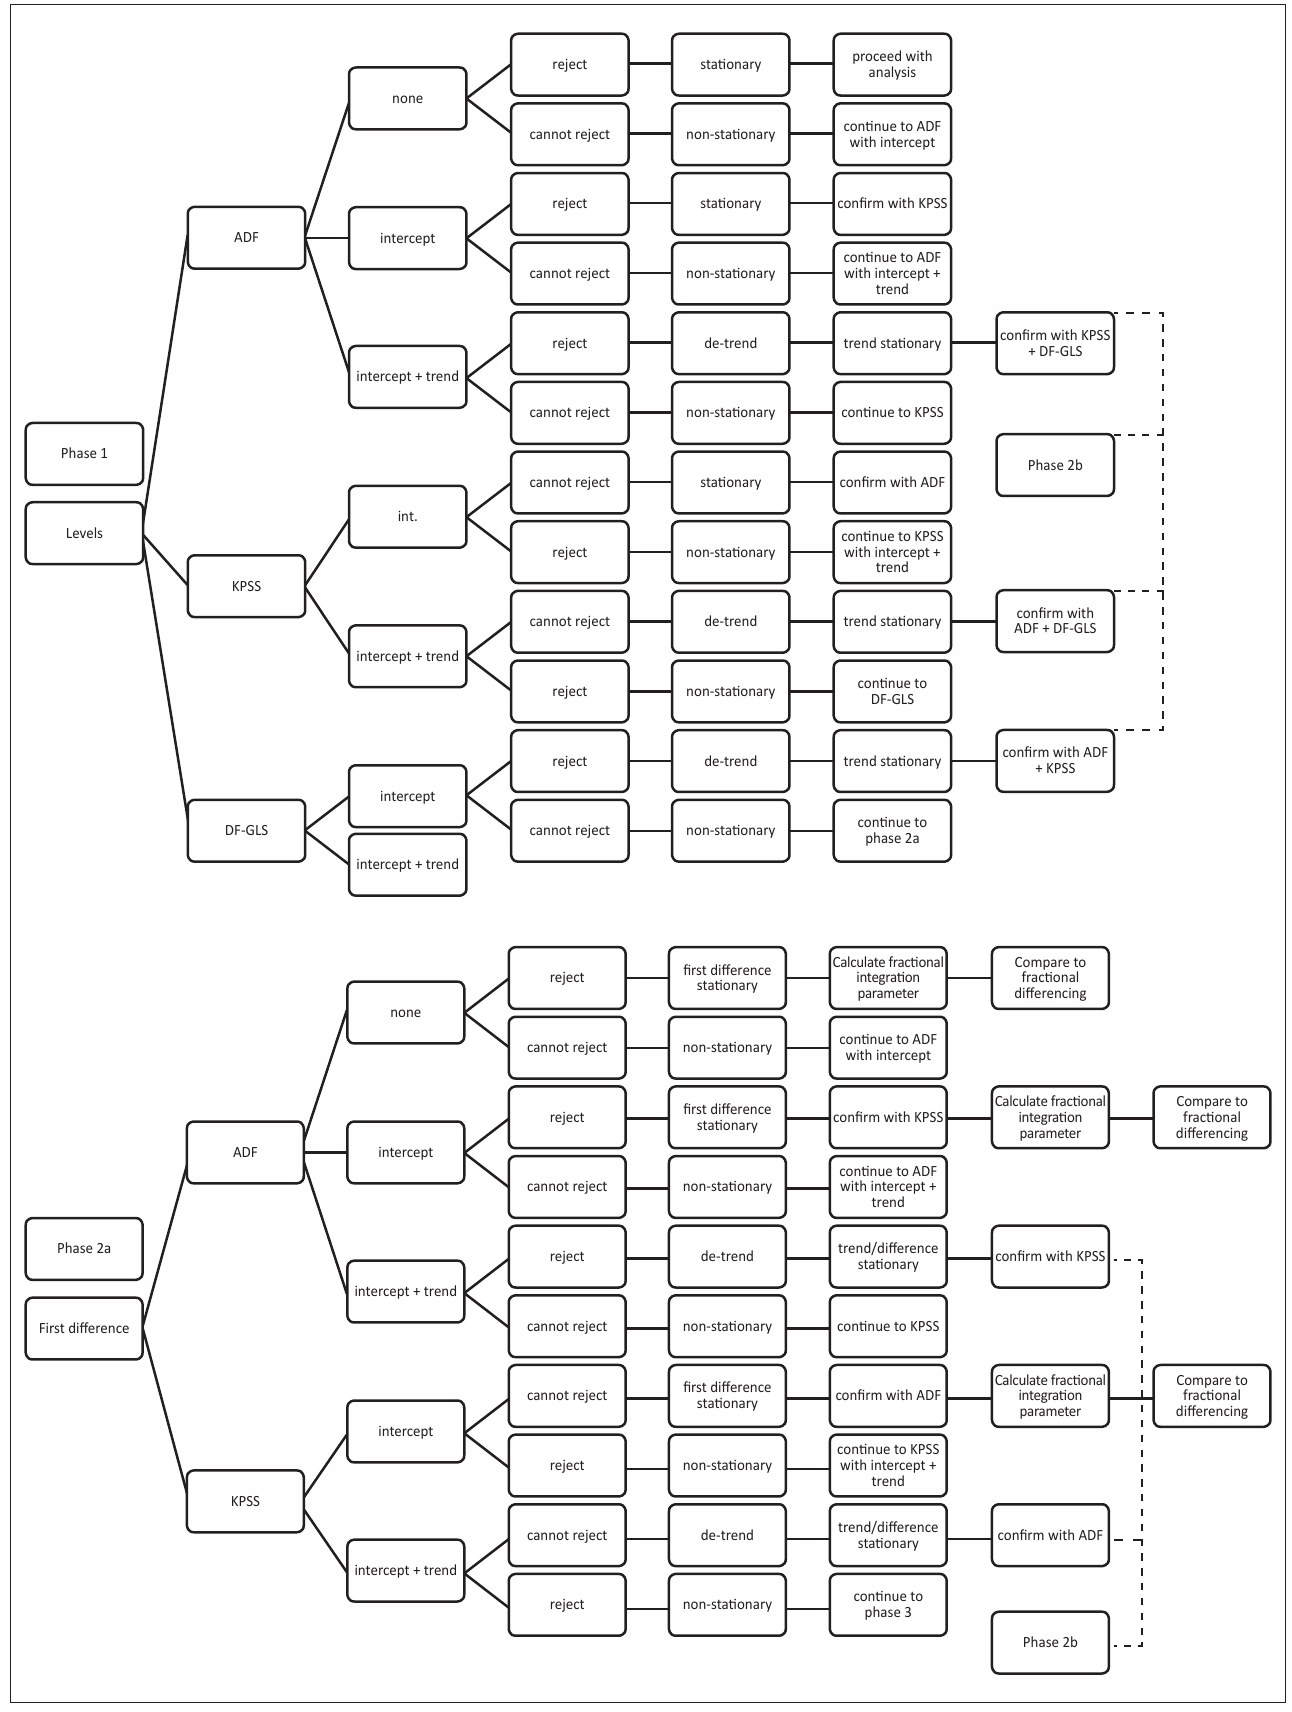
FIGURE 1A: The process of rendering a non-stationary time series stationary (Phases 1, 2 and 3).